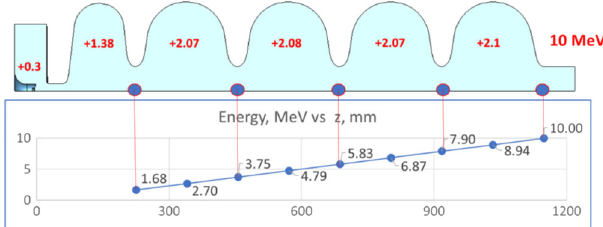
FIG. 11. Beam transport through the five-cell SRF cavity: cell- by-cell bunchenergygain(left)andoutput beamparameters(right).